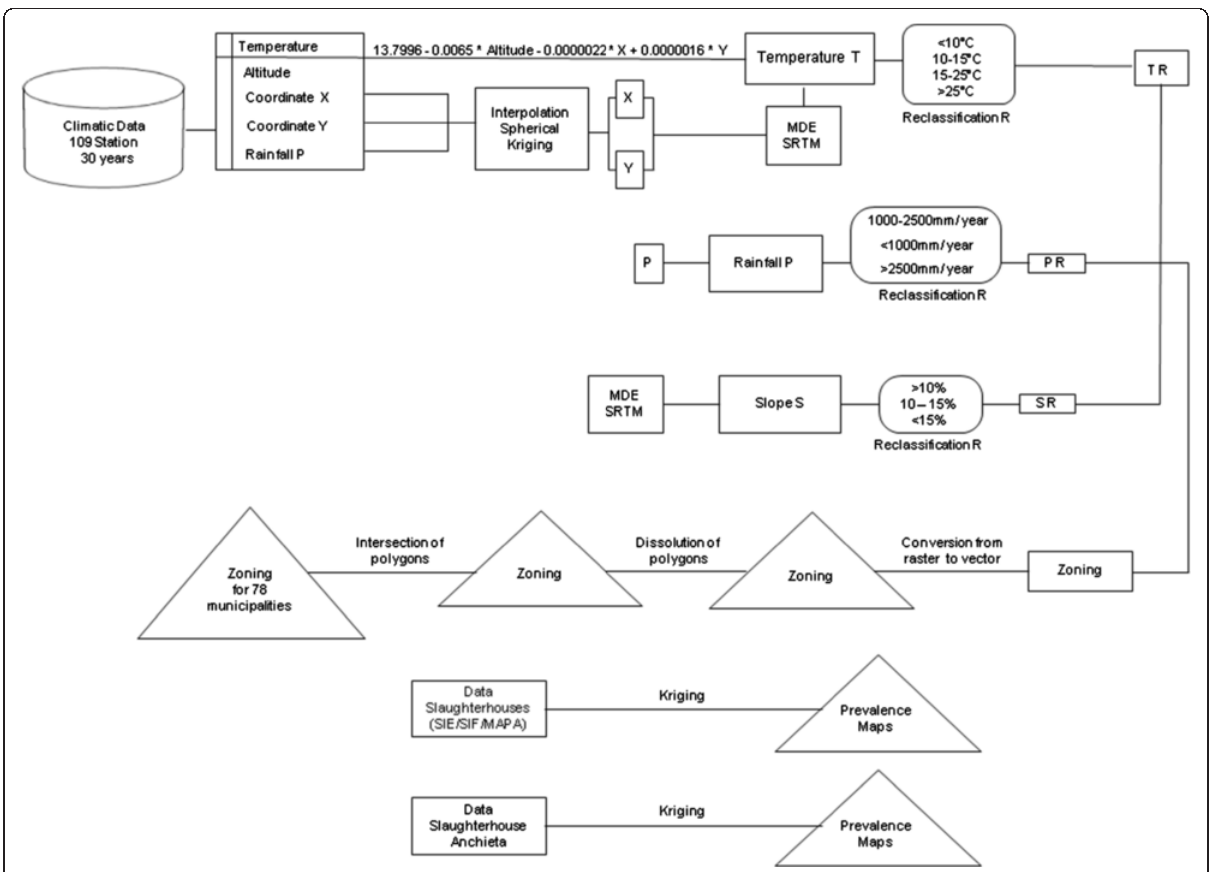
Figure 1 Flowchart statement about the steps performed for the generation of the bioclimatic distribution and prevalence